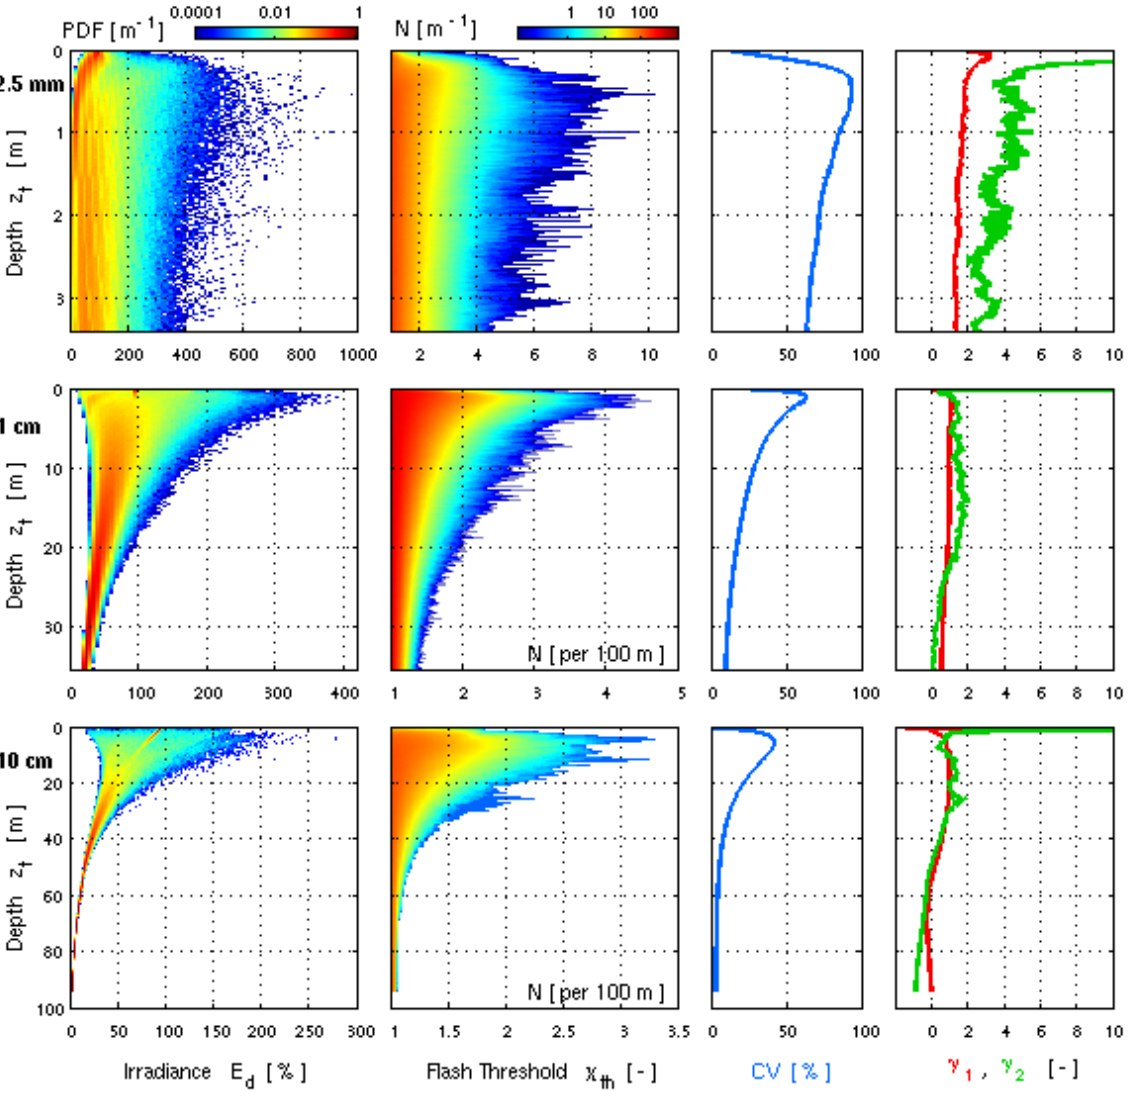
Fig. 8. Statistical evaluation of the modeled light field for 30 October 2009; top: near the surface with 2.5mm resolution, middle row: dx = 1cm, and lower panels: dx = 10cm; each shown the probability density function PDF , frequency of flashes N above a certain threshold χ th , coefficient of variation CV , and PDF skewness γ 1 , and excess kurtosis γ 2 Figure 8. Statistical evaluation of the modeled light field for 30 Oct. 2009; top: near the 3 surface with 2.5 mm resolution, middle row: dx = 1 cm, and lower panels: dx = 10 cm; each 4